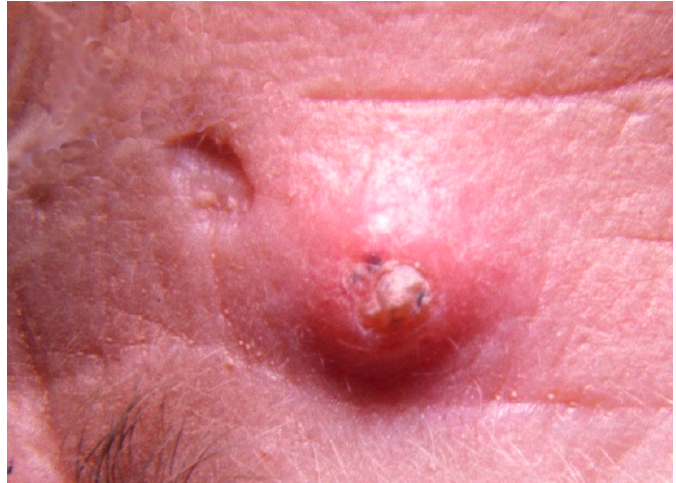
Figure 1. A small (5 mm) self-healing epithelioma with a central keratin plug adjacent to a pitted scar at the site of a lesion that resolved spontaneously.